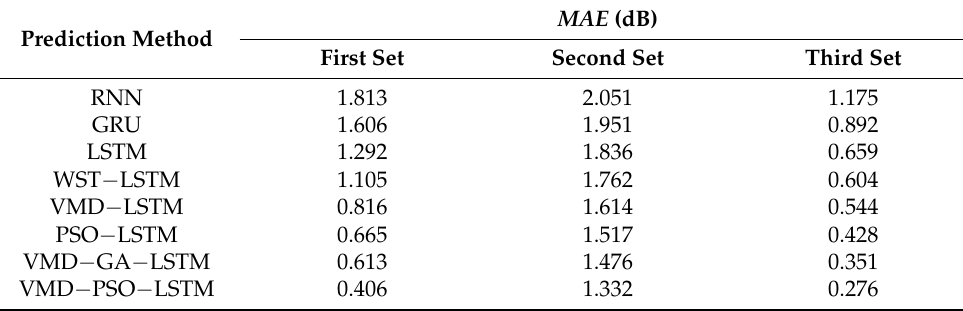
Table 11. MAE of different prediction methods for three sets of PL